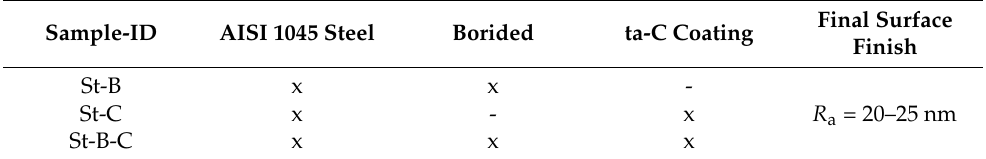
Table 1. Samples prepared for this study with